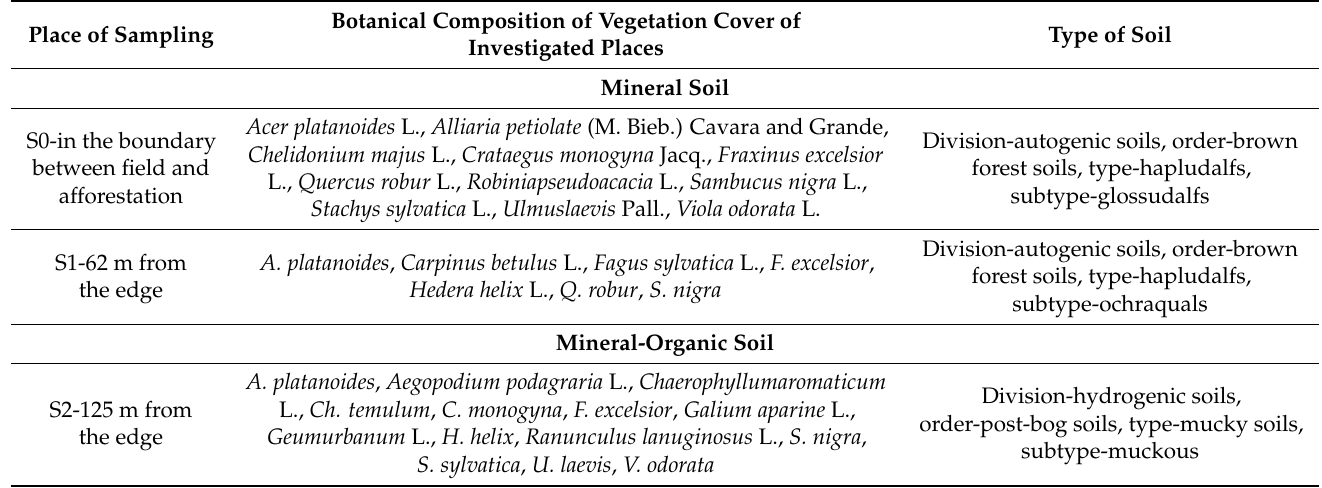
Table 1. Shelterbelt places and some properties of